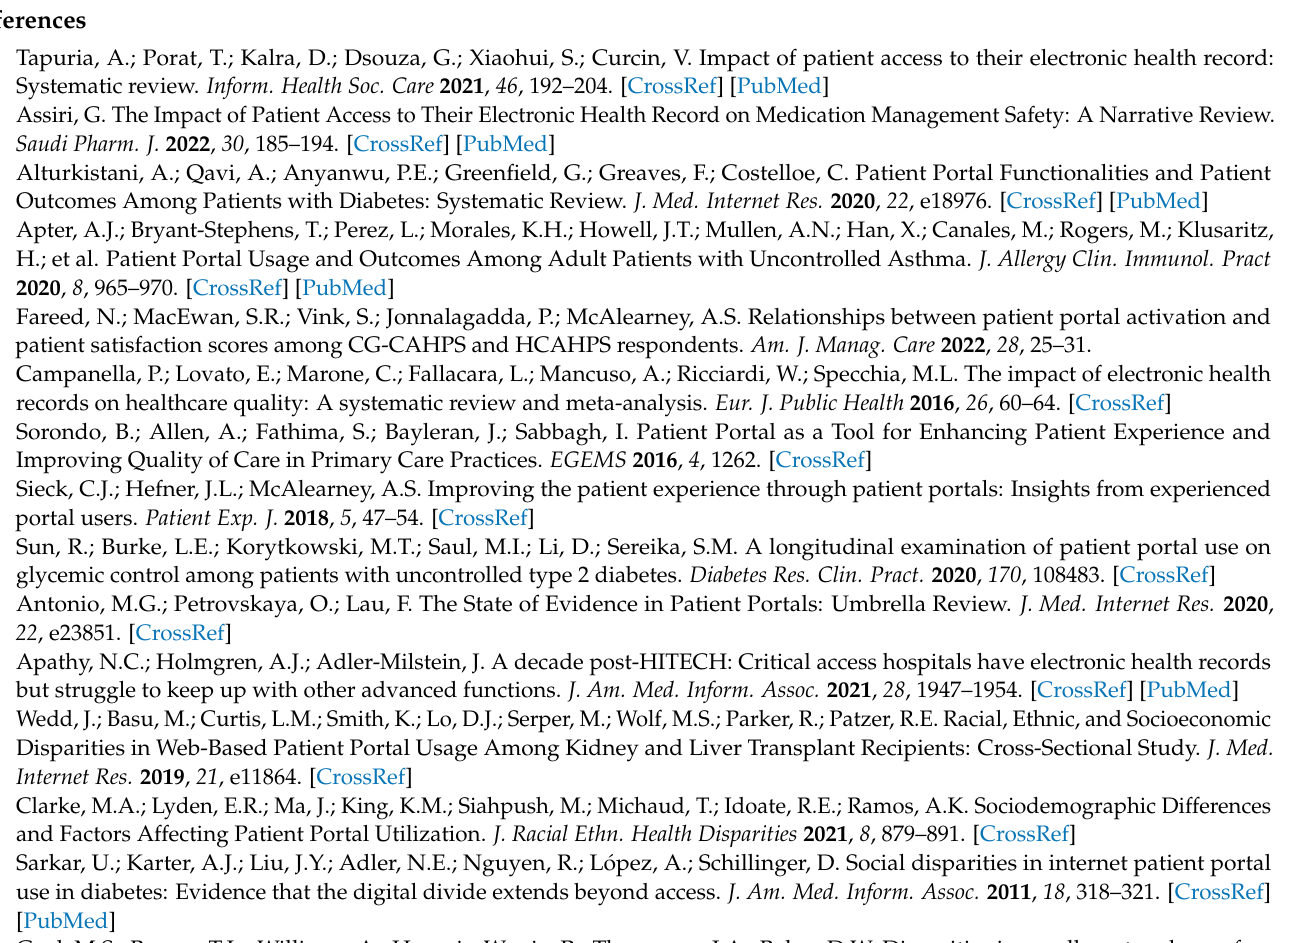
Figure A1. Patient portal core functions.